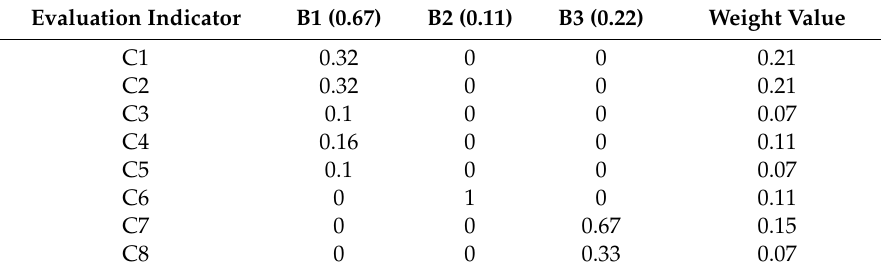
Table 7. The weight values of evaluation indicators in the index layer. Evaluation Indicator